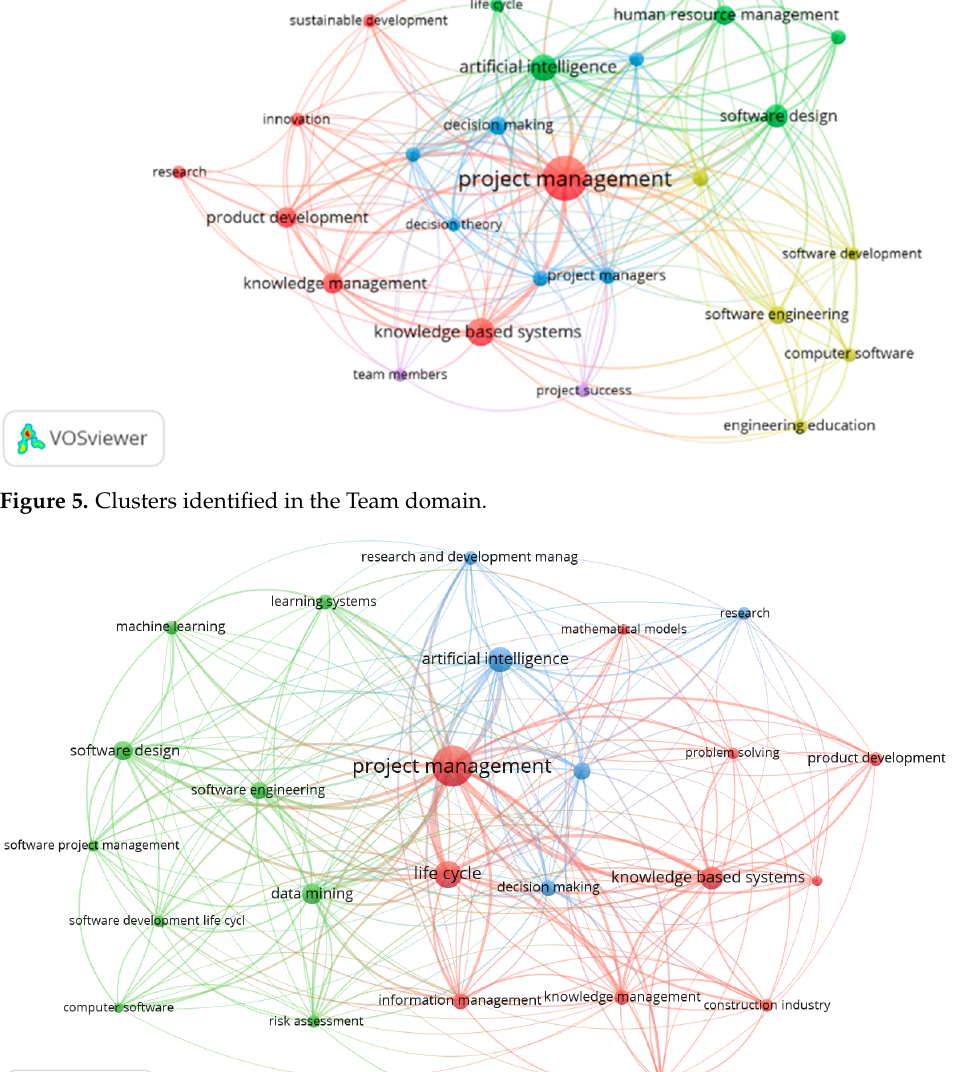
Figure 6. Clusters identified in the Life Cycle domain.